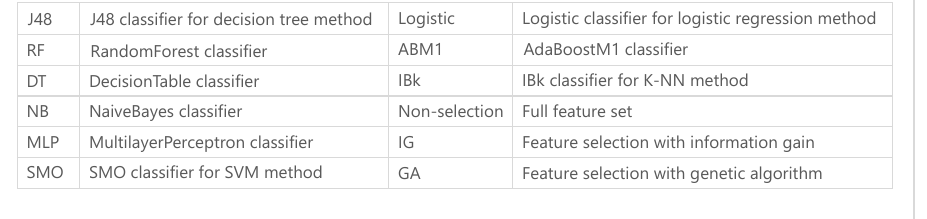
Figure 6. A graph comparing F1 scores among feature selection